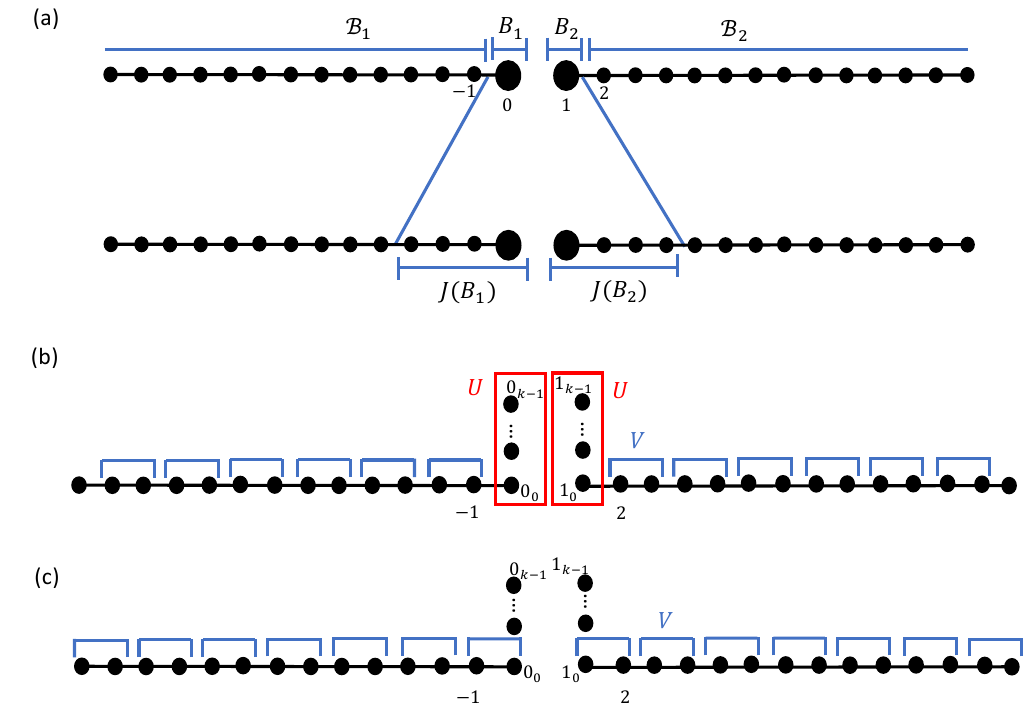
Figure 9 . Lattice toy model for an eternal black hole coupled to an infinite bath. The subsystem at two sites, 0 and 1 , describes the black hole. Various regions of interest are shown in (a). (b) and (c) show the time evolution. We imagine that site 1 consists of k = log interact among one another, and one of them, 1 0 is coupled to 2 . Similarly with site 0 .